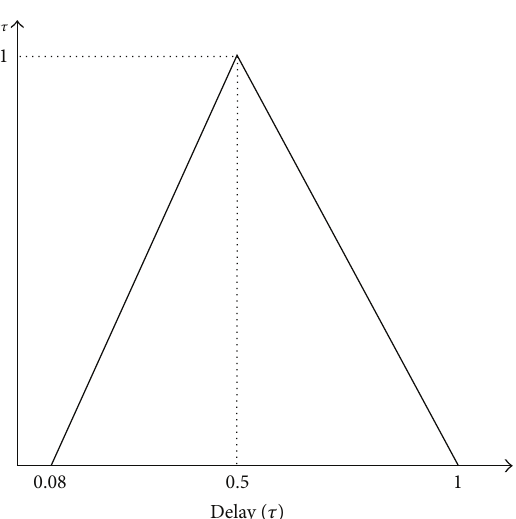
Figure 6: Distribution of possibilities for the delay ( 𝜏 ).